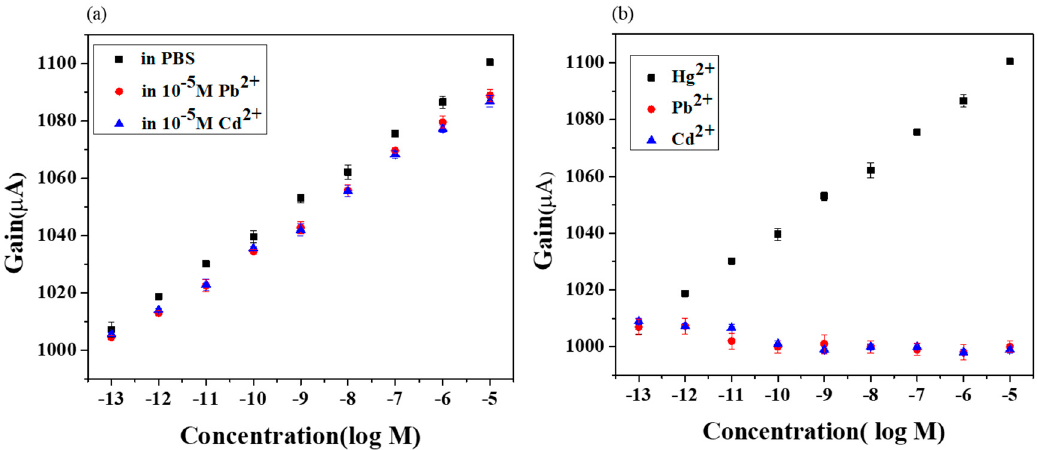
Figure 6. Selectivity characteristics of extended gate Hg-ISMFET sensor measured at 1 V Vg. ( a ) Gain versus heavy metal ion concentration graph of Hg-ISMFET, using fixed interference method. ( b ) Gain versus heavy metal ion concentration graph of Hg-ISMFET, using separate solution method (error bars obtained from multiple tests with n = 3).